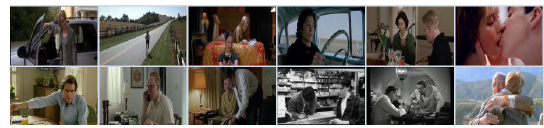
Figure 15. Exemplar frames from Hollywood2 dataset.